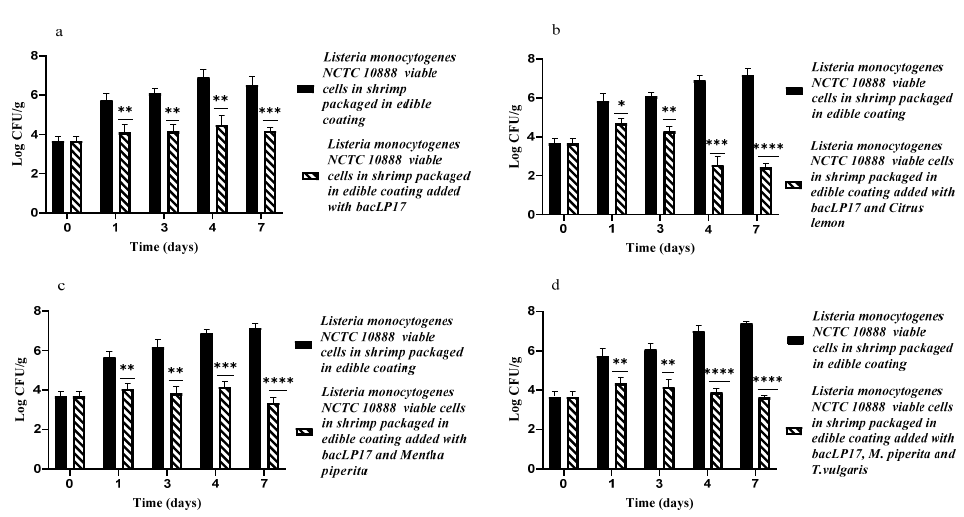
Figure 3. Coating together with bacLP17 ( a ) and with the best combination bacLP17/EOs: bacLP17/ Citrus lemon ( b ), bacLP17/ M. piperita ( c ), bacLP17/ M. piperita / T. vulgaris ( d ), applied on artificially contaminated shrimp samples. Experiments were performed in triplicate p -values of < 0.05 (*), p < 0.01 (**), p < 0.001 (***) and p < 0.0001 (****) were considered significant by t -test and ANOVA.